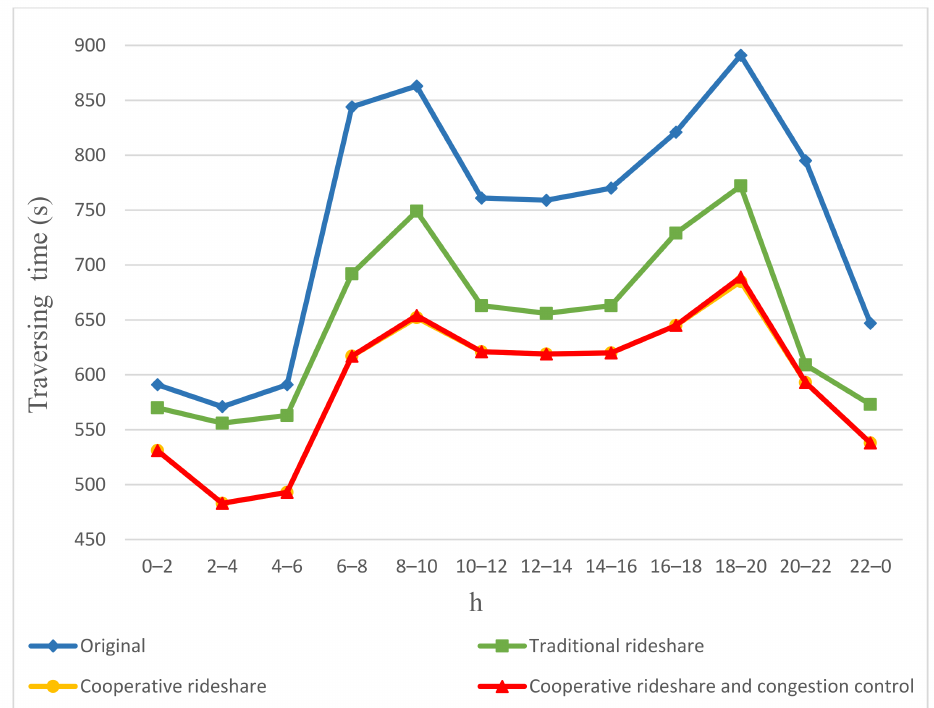
Figure 18. Traversing times of PEV/SAEV passengers on minor arterial